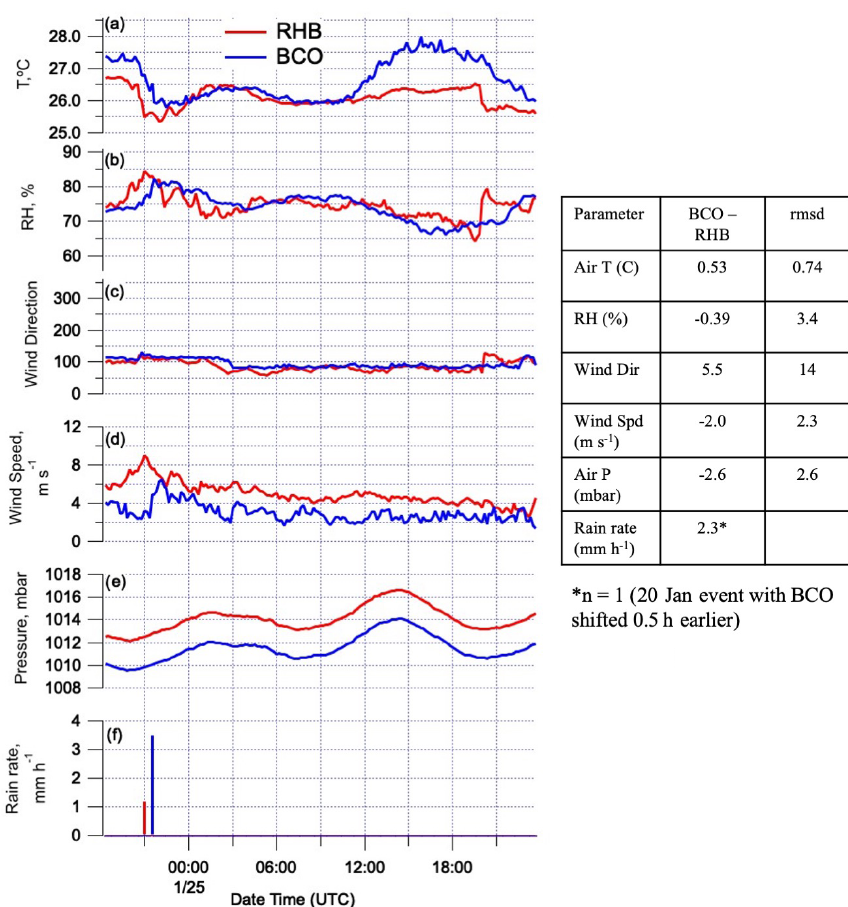
Figure 7. Meteorological parameters measured during the RV Ronald H. Brown ( RHB ) and the Barbados Cloud Observatory (BCO) com- parison (24 January, 18:20 to 25 January, 23:40) when RHB was 20nmi due east of BCO. Parameters include (a) atmospheric tempera- ture, (b) relative humidity (RH), wind direction, wind speed, atmospheric pressure, and rain rate. The average of the absolute differences (BCO − RHB ) and root mean square differences (RMSDs) are reported in the inset table. BCO meteorological sensors were located at 30ma.s.l. and were not adjusted to a height of 10m. Number of samples based on 10min averaged data =